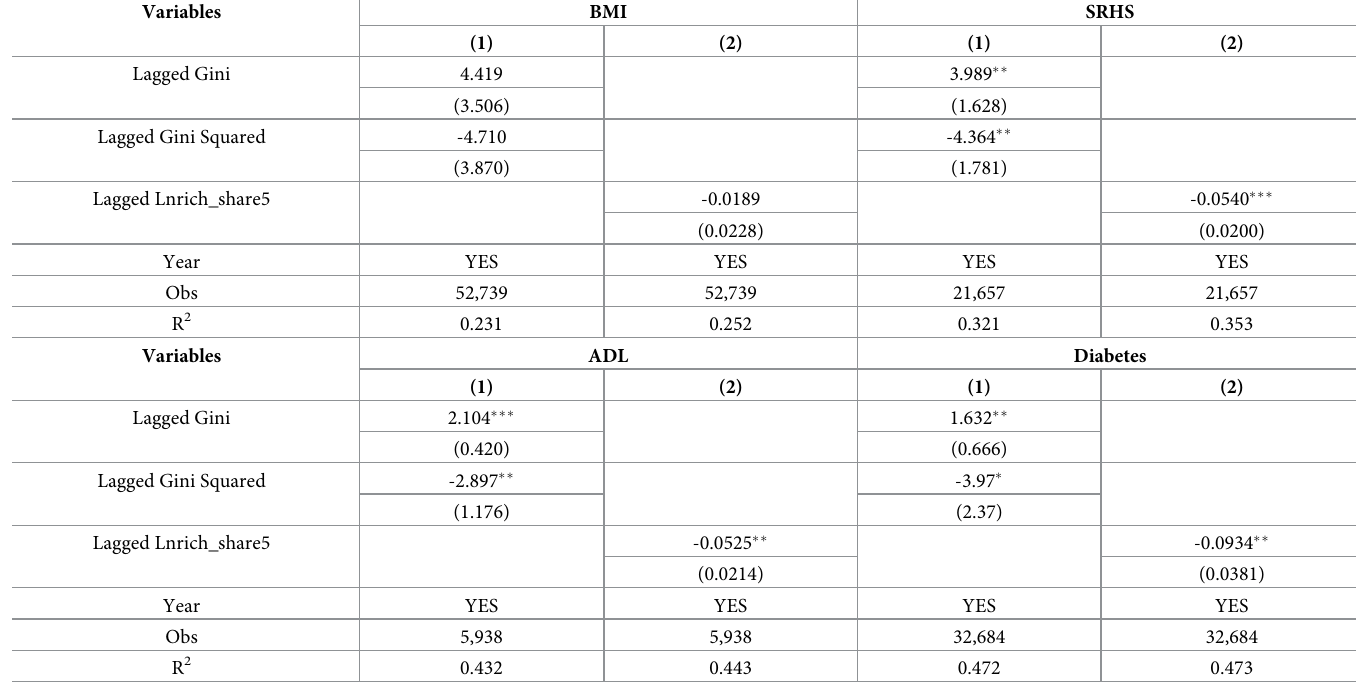
Table 13. The effects of lagged income inequality on